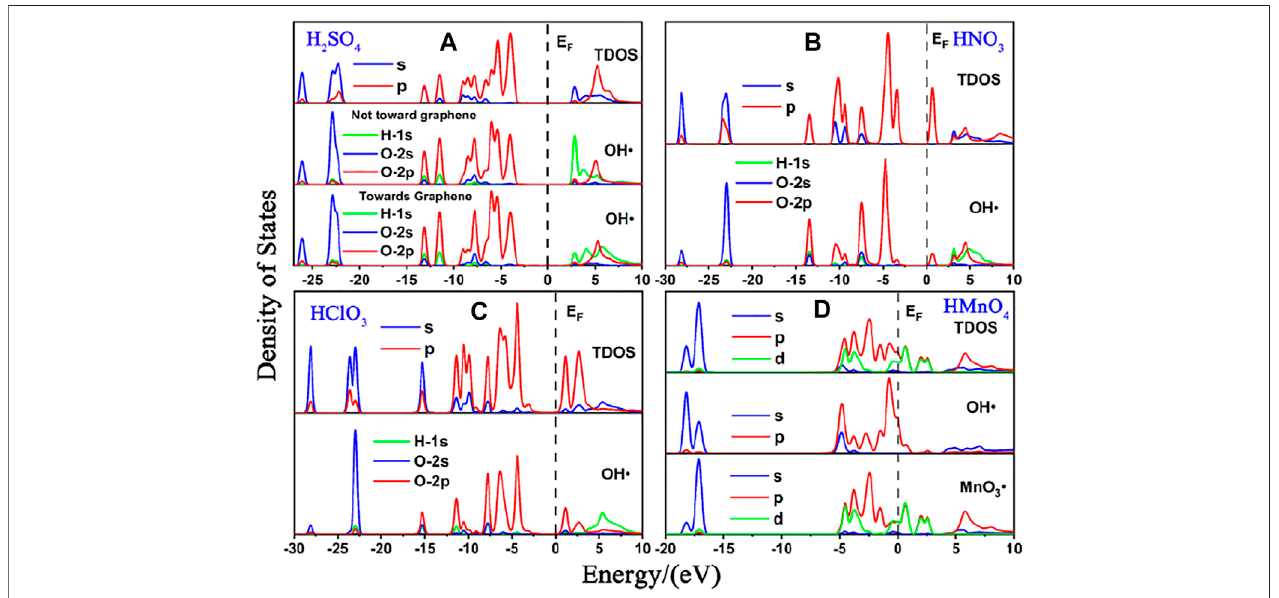
(cid:129) . Particularly, there is also